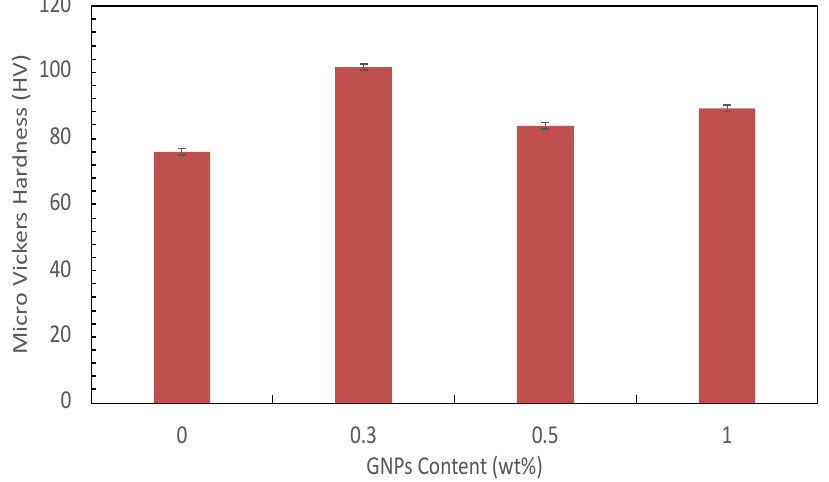
Figure 8. Relative density of thixoformed composite sample.